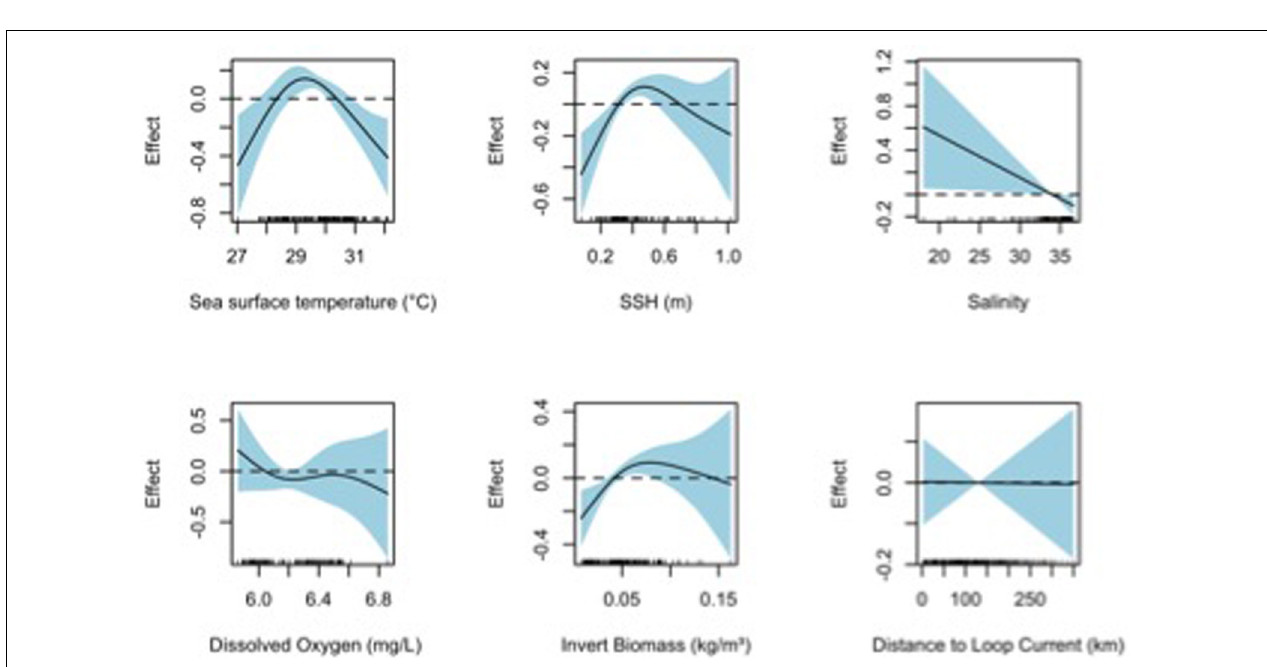
FIGURE 7 | Response plots for 2016 oceanographic variable of the bongo net Shannon diversity ( H’ ) from full generalized additive model (GAM). Plots include sea surface temperature ( ◦ C), sea surface height (m), salinity, dissolved oxygen (mg L − 1 ), invertebrate biomass (kg m − 3 ), and distance to Loop Current (km). Solid lines represent smoothed values and the shaded area represents 95% confidence intervals. Dashed line displayed at y = 0 on response plots.